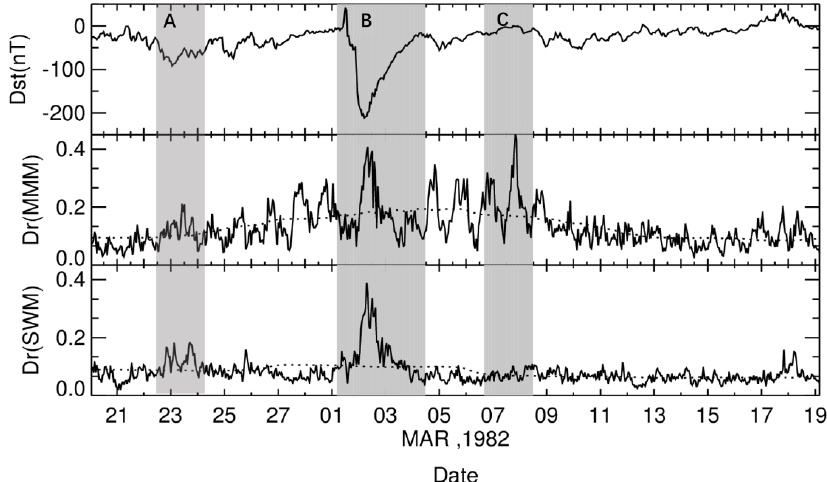
Figure 1. From top to bottom: Dst geomagnetic index, ionospheric index Dr (MMM), and ionospheric index Dr (SWM) indices. The dotted lines represent smoothed Dr trends. The scale values in the x -axis mean the 00:00 UT (universal time) in one day. The shade of ( A ) and ( B ) represent the period of geomagnetic disturbance; the shade of ( C ) denotes geomagnetic quiet time.